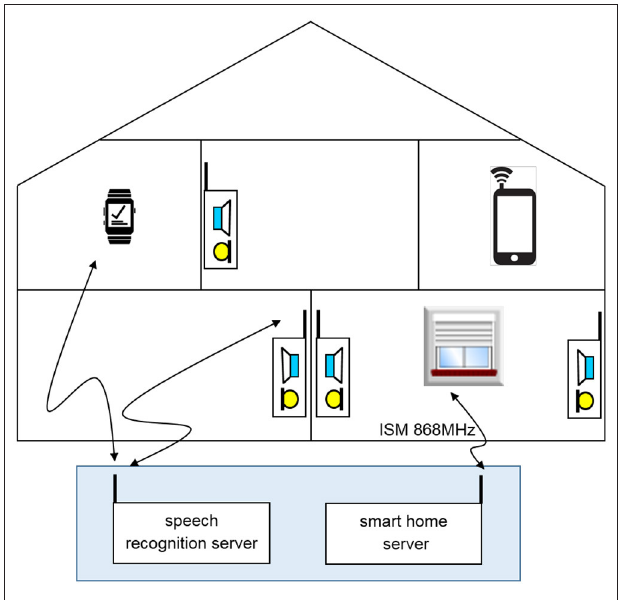
FIGURE 1 | Smart home control with local client and server systems.